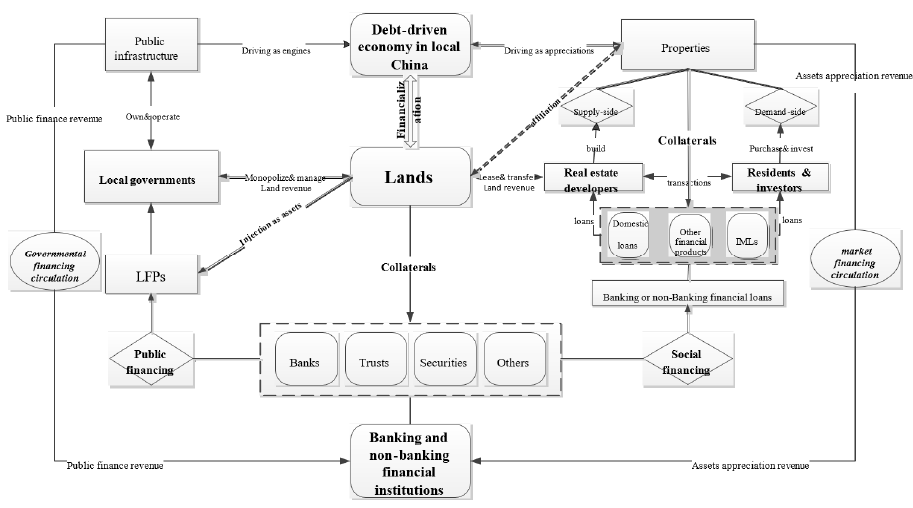
Figure 5. Debt-driven economy mechanism after the GFC in local China.